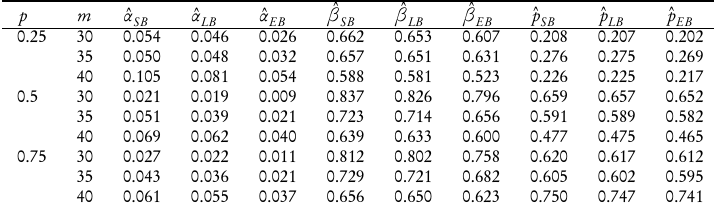
Bayes estimates of α , β and p based on cancer patient data under squared error, LINEX and entropy loss functions for different choices of p = 0.25,0.5 and 0.75